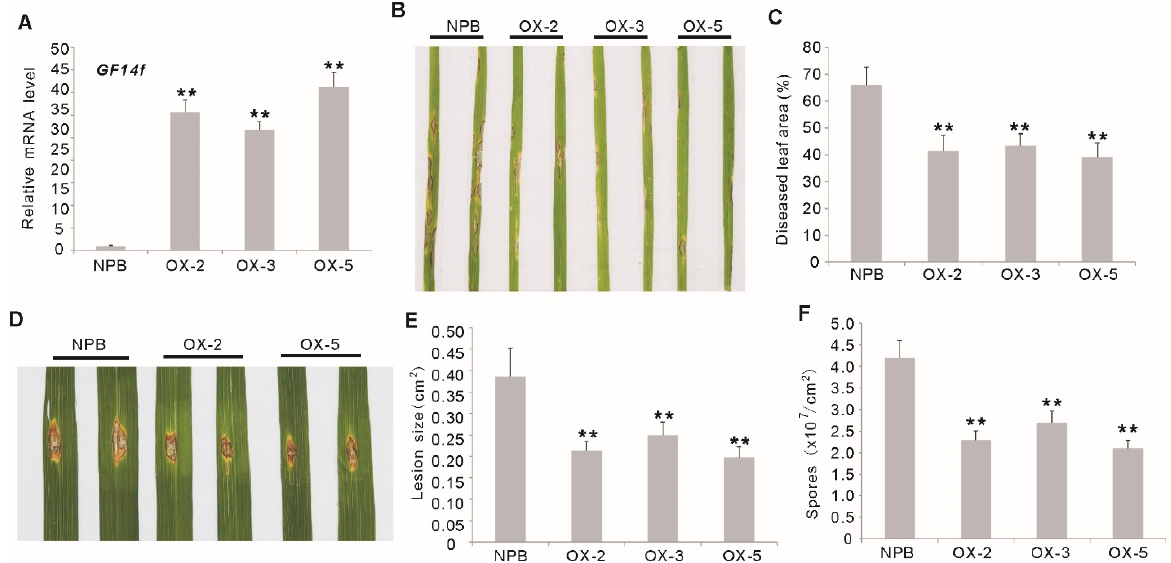
Figure 2. Disease phenotypes of the OsGF14f -overexpressing ( OXGF14f ) plants (OX-2, OX-3, OX-5) after leaf blast infection. ( A ) Transcription analysis of OsGF14f in the OXGF14f plants by quantitative RT-PCR. ** p < 0.01. ( B ) Disease phenotypes of the OXGF14f plants and Nipponbare plants after spraying inoculation with M. oryzae isolate GD08-T13 for six days. ( C ) Diseased leaf area (DLA) in the OXGF14f plants and Nipponbare plants after leaf blast inoculation for 6 days. Error bars indicate the SD from at least ten biological replicates. ** p < 0.01. ( D ) Disease phenotypes of the OXGF14f plants and Nipponbare plants after inoculation with M. oryzae isolate GD08-T13 using punch method at 6 weeks after sowing. ( E ) Relative lesion size in the OXGF14f plants and Nipponbare plants after leaf blast inoculation. Error bars indicate the SD from at least ten biological replicates. ** p < 0.01. ( F ) Numbers of spores produced on the OXGF14f plants and Nipponbare plants after punch inoculation. Error bars indicate the SD from three biological replicates. ** p < 0.01.